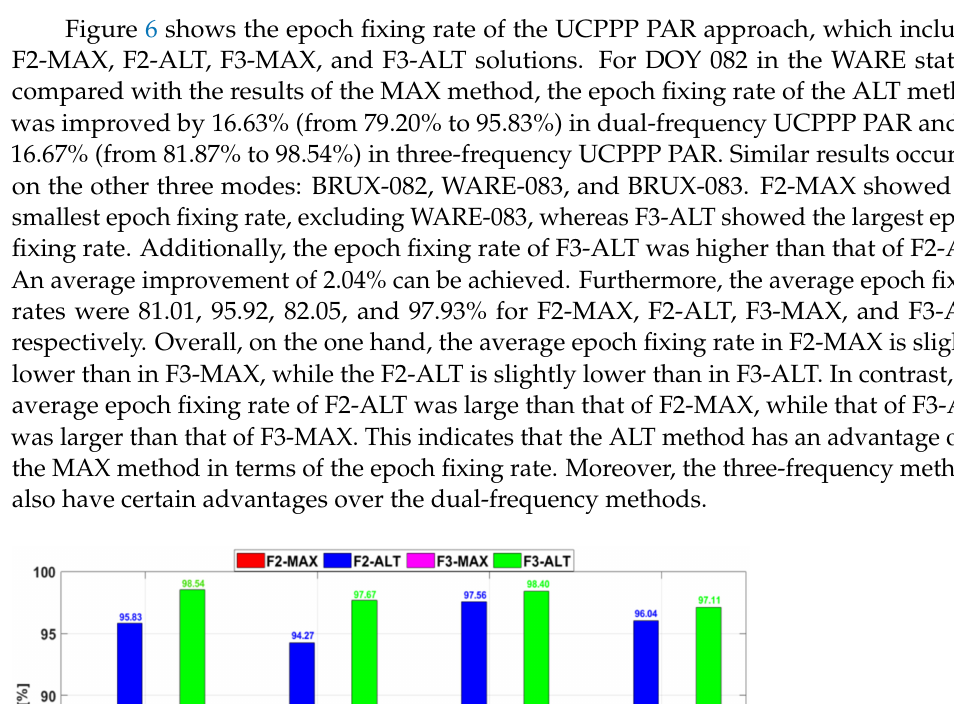
Figure 5. Ratio distribution of UCPPP PAR.